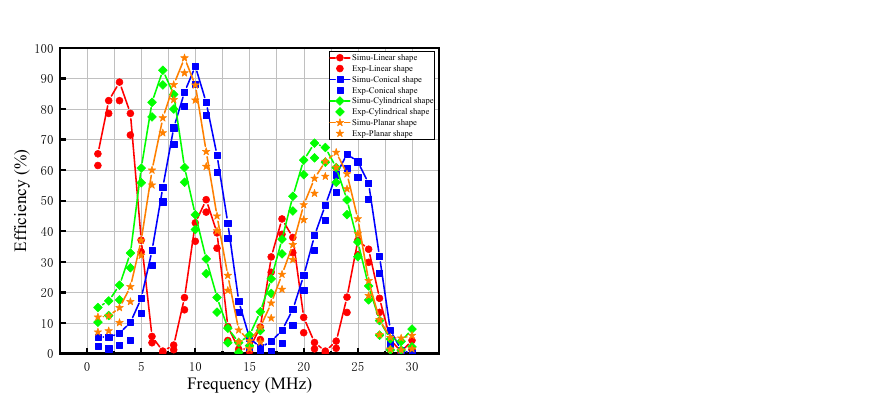
( b ) Figure 14. Comparison of simulation and experimental data of transfer structures under asymmetry: ( a ) length of transmitting structure; ( b ) length of receiving structure.